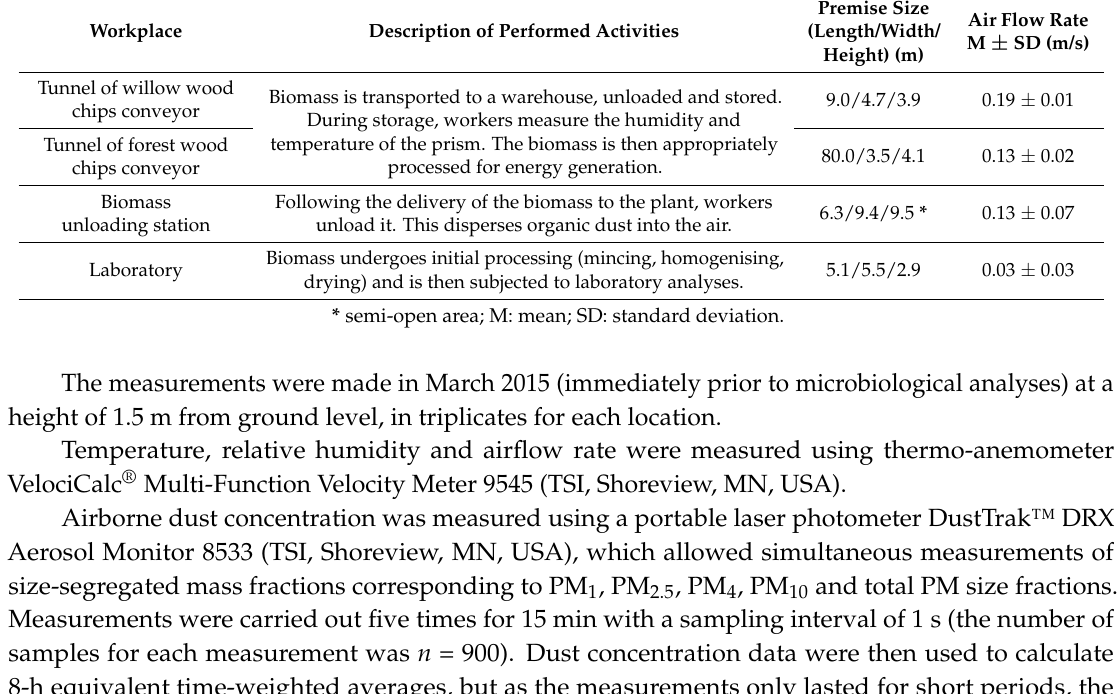
Table 1. Characteristics of selected workplaces at the thermal power station processing biomass. Workplace Description of Performed Activities Tunnel of willow wood Biomass is transported to a warehouse, unloaded and stored. chips conveyor During storage, workers measure the humidity and temperature of the prism. The biomass is then appropriately Tunnel of forest wood processed for energy generation. chips conveyor Biomass Following the delivery of the biomass to the plant, workers unloading station unload it. This disperses organic dust into the air. Biomass undergoes initial processing (mincing, homogenising, drying) and is then subjected to laboratory